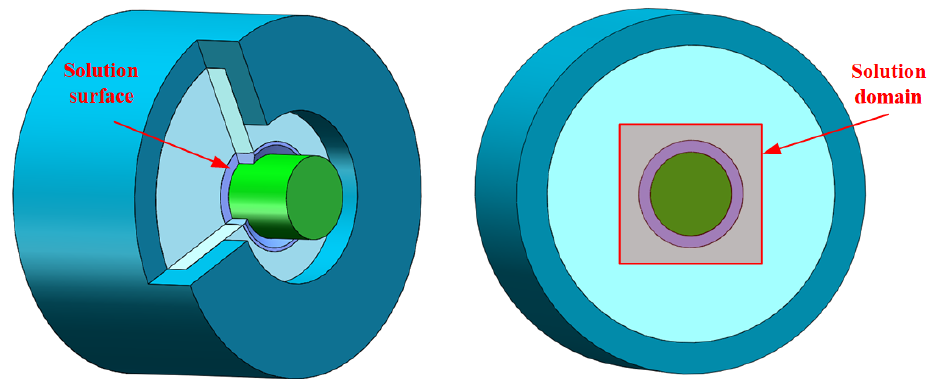
Figure 13. Magnetic field solution surface and solution domain.